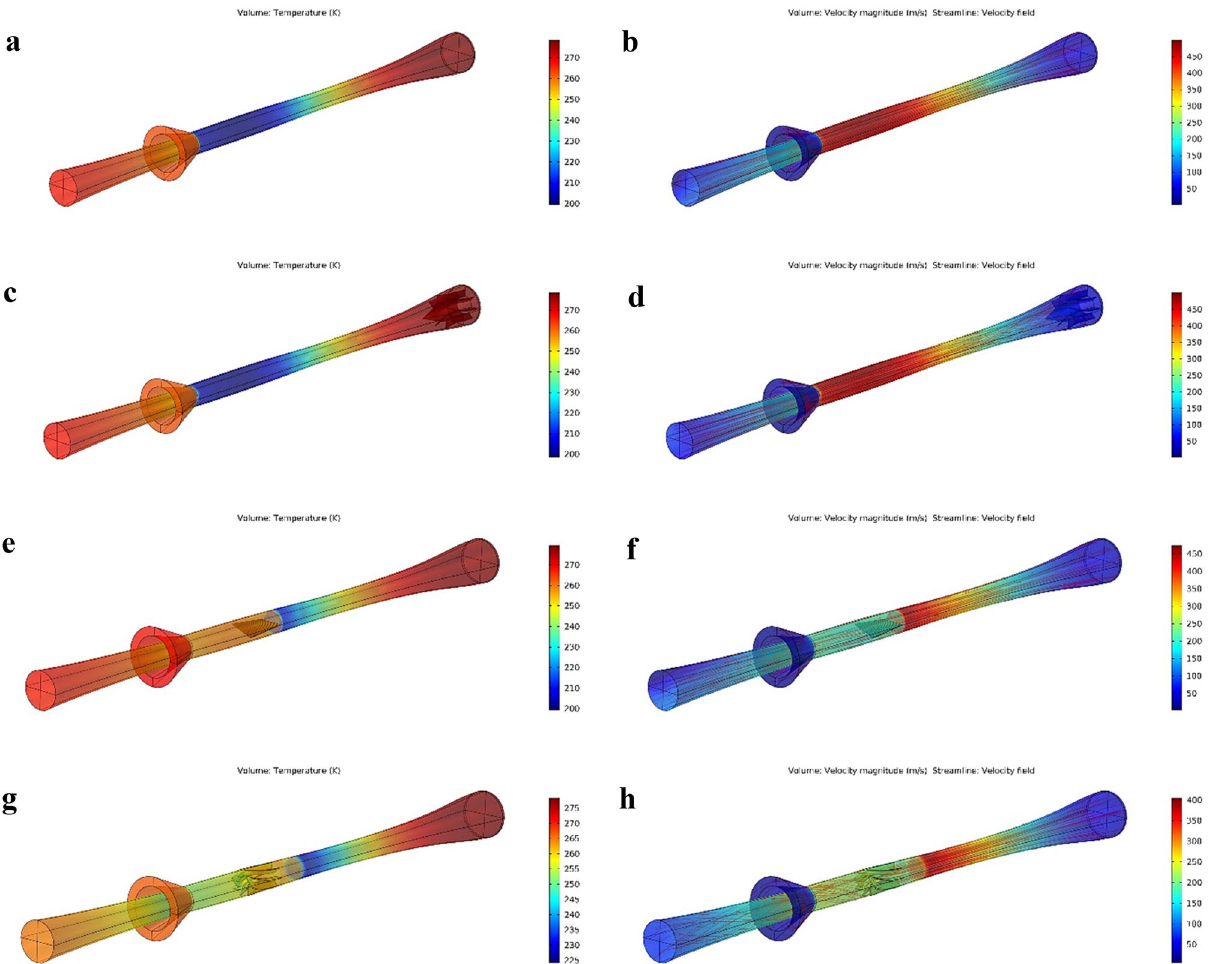
Figure 8. Temperature ( a , c , e , g ) and velocity ( b , d , f , h ) profiles for simple 3S (a, b ), 3S quipped with axial swirler ( c , d ), 3S quipped with helical swirler ( e , f ) and 3S quipped with wall mounted swirler ( g , h